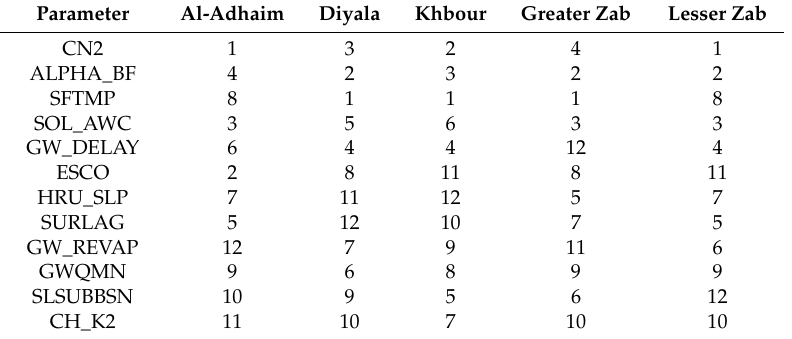
Table 2. Ranks of the 12 highest sensitive parameters related to streamflow in the five basins. Parameter Al-Adhaim Diyala Khbour Greater Zab Lesser Zab CN2 1 3 2